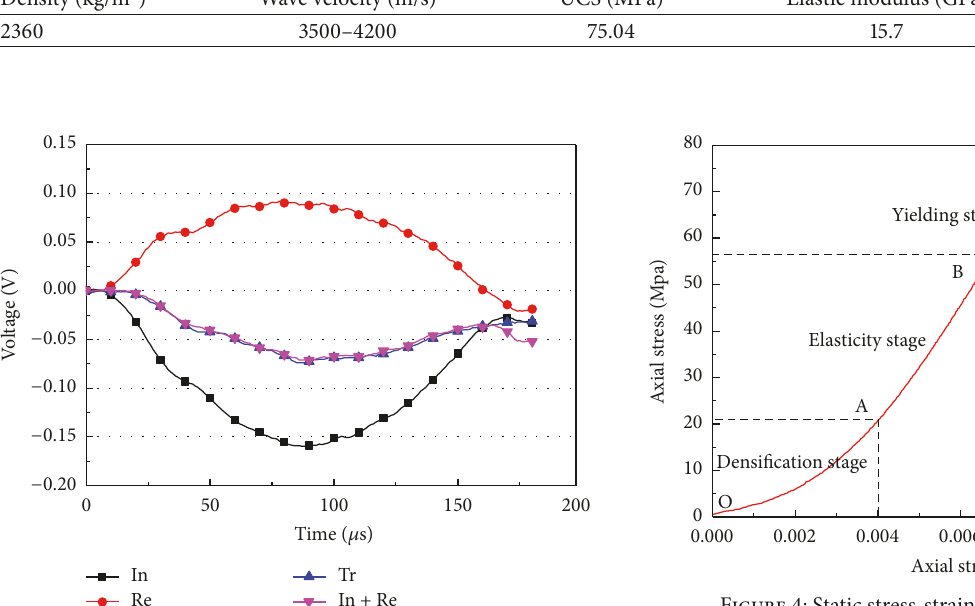
Figure 4: Static stress-strain curves of sandstone.